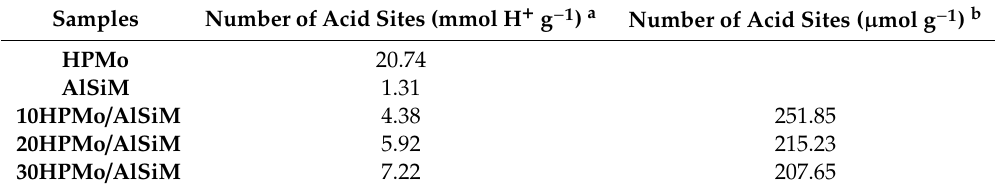
Table 4. Evaluation of the number of acid sites in catalyst materials.